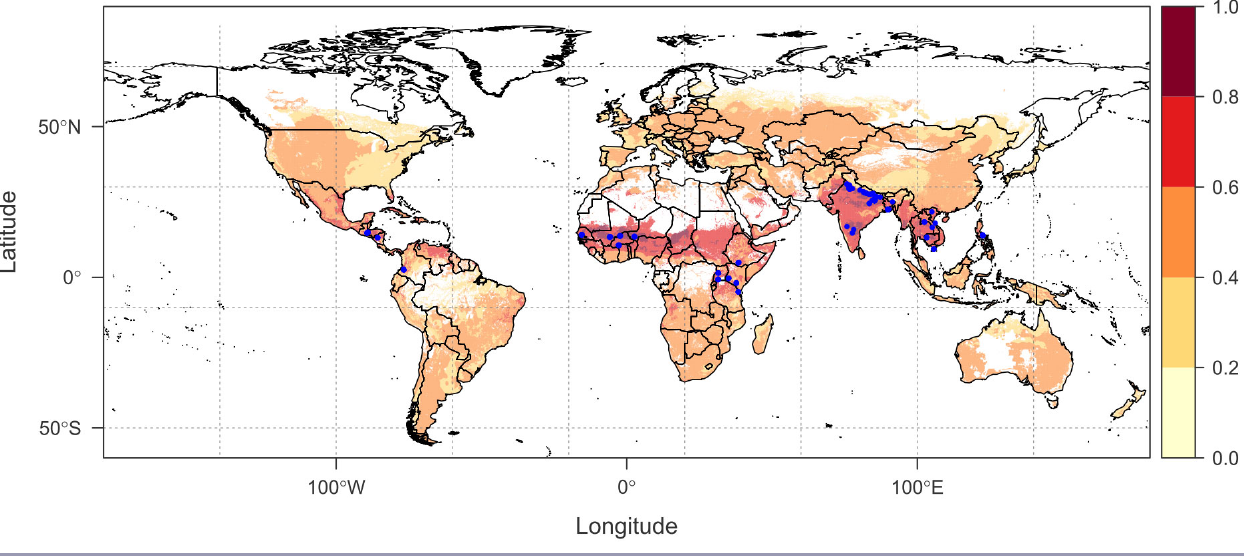
Fig. 5. Global representativeness of the CSV network (blue dots). For each pixel, the value reported corresponds to the maximum similarity between the pixel’s climate and all the climate-smart